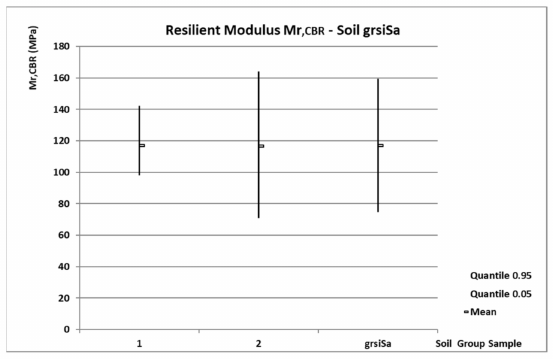
Figure 8. Statistical quantities—mean, 0.05 quantile, 0.95 quantile of M r,CBR for grsiSa soil.